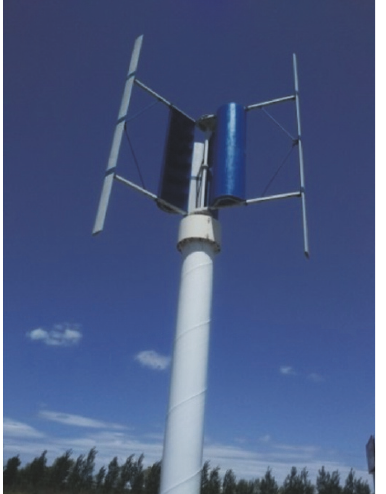
Figure 19: Actual machine of wind turbine.